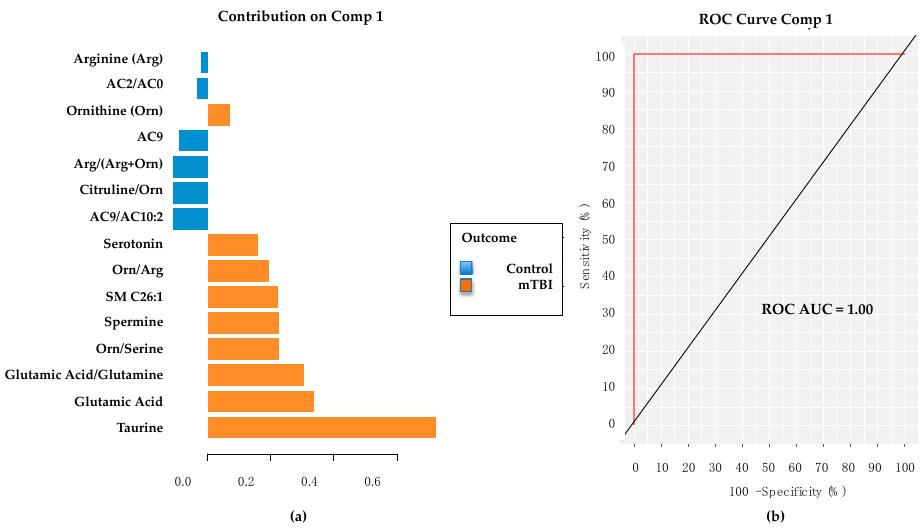
Figure 3. Targeted metabolomic panel and classification performance. Using the sPLS-DA methods in mixOmics , this 15-member metabolite panel was derived ( a ) featuring primarily amino acids, biogenic amines and specific metabolite ratios. This particular targeted metabolite panel classified subacute mTBI subjects from TBI controls with a ROC AUC = 1.0. ( b ) Note the two metabolites with the highest contribution are Taurine and Glutamic Acid. Comp 1 = feature selection component 1. mTBI = mild traumatic brain injury. ROC = receiver operating characteristic. AUC = area under the curve. AC = acylcarnitine. SM = sphingomyelin.